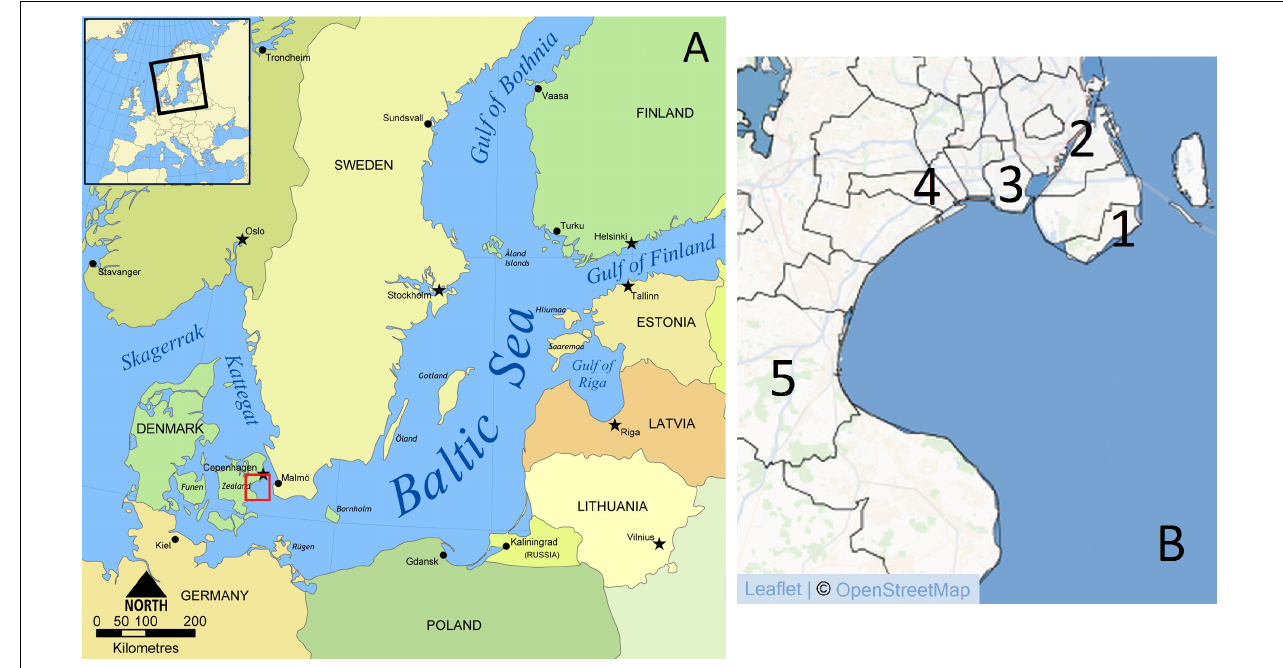
FIGURE 1 | (A) Overview map of the Baltic Sea region, with Køge bay marked with a red square. (B) Zoom to Køge Bay and the five municipalities of Dragør (1), Copenhagen (2), Hvidovre (3), Ishøj (4), and Køge